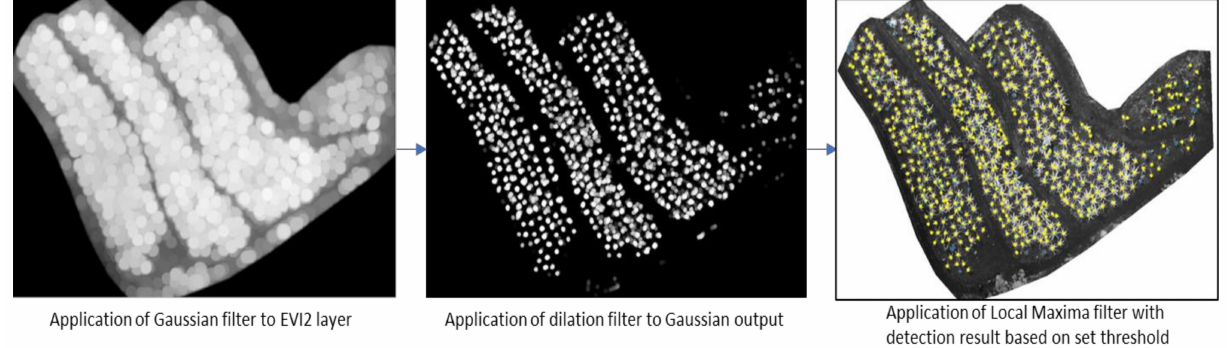
Figure 7. Overview of workflow and example outputs for local maximum filter (LMF) based on the Enhanced Vegetation Index 2 (EVI2) layer within the eCognition Developer software for the classification of individual banana